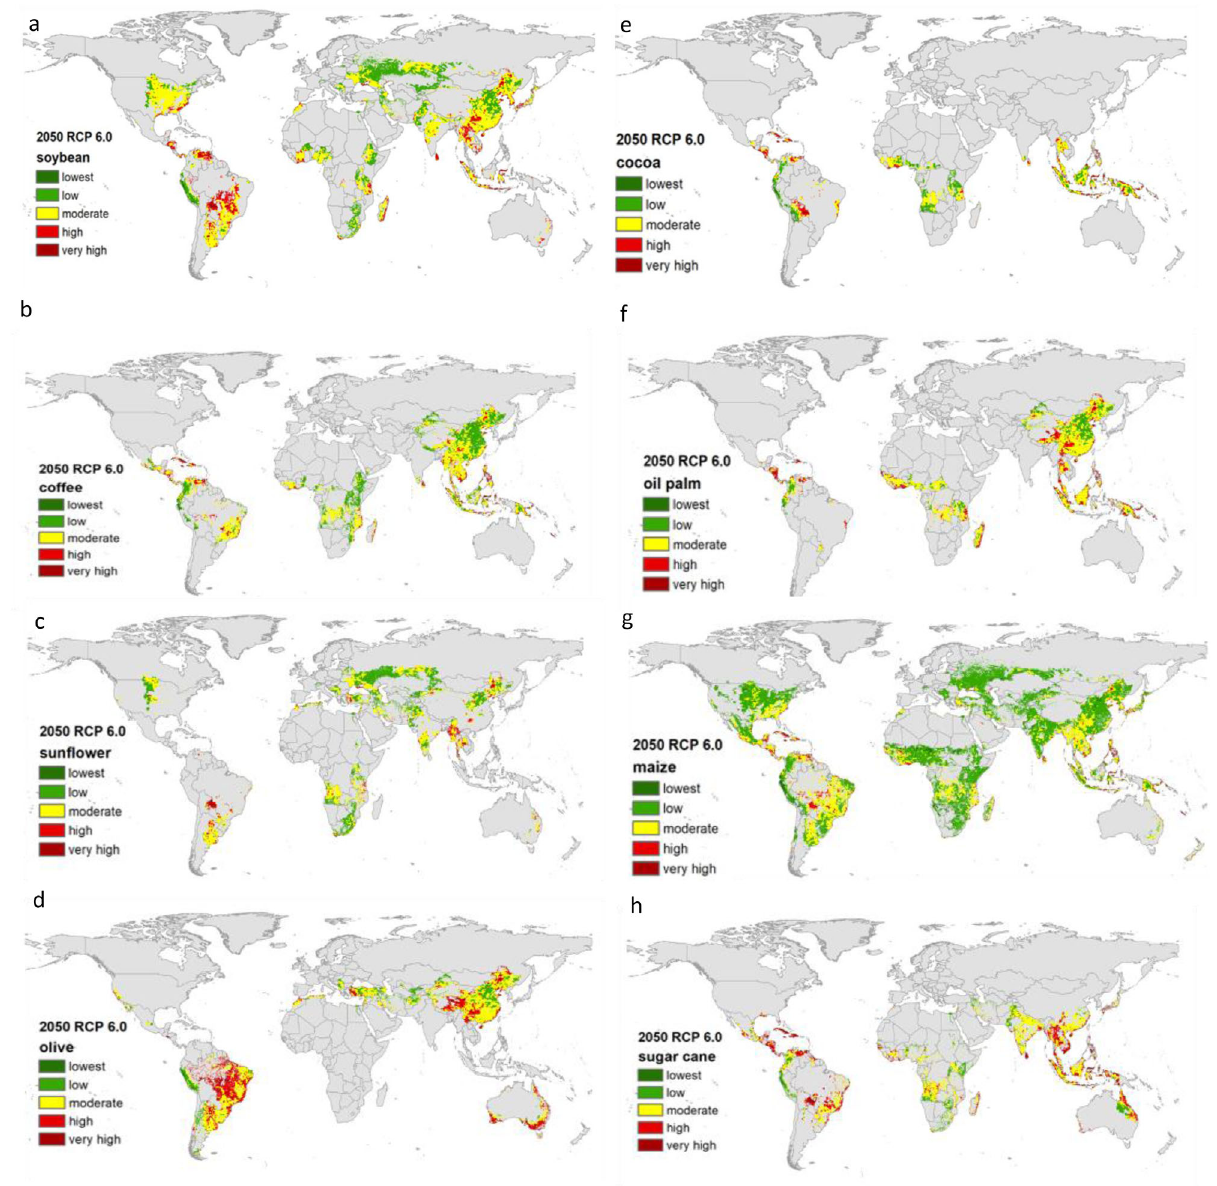
Fig. 5 Climate vulnerability level maps of the key agricultural products imported by the EU to drought in 2050 under the RCP 6.0 concentration pathway. Left column from top to bottom: soybean ( a ), coffee ( b ), sun fl ower ( c ), olive ( d ). Right column from top to bottom: cocoa ( e ), oil palm ( f ), maize ( g ), sugar cane ( h ). Green to red colors refers to vulnerability levels, from the lowest to very